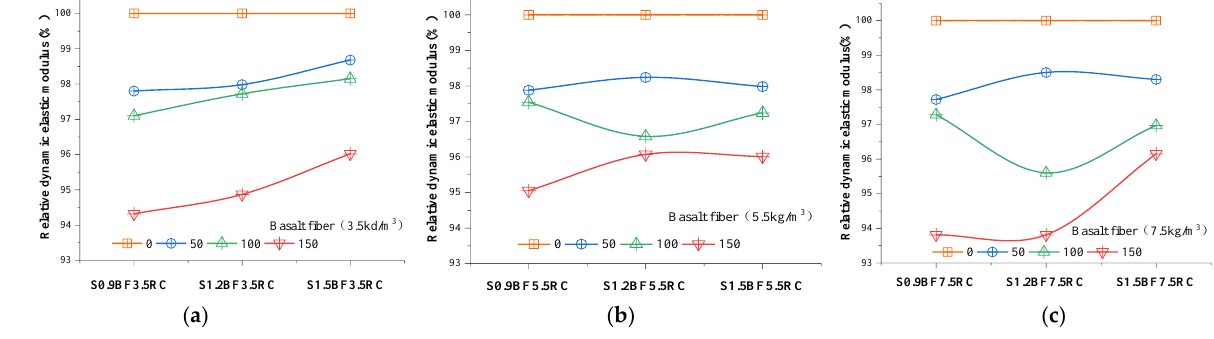
Figure 5. ( a – c ) Comparison of relative dynamic elastic modulus.